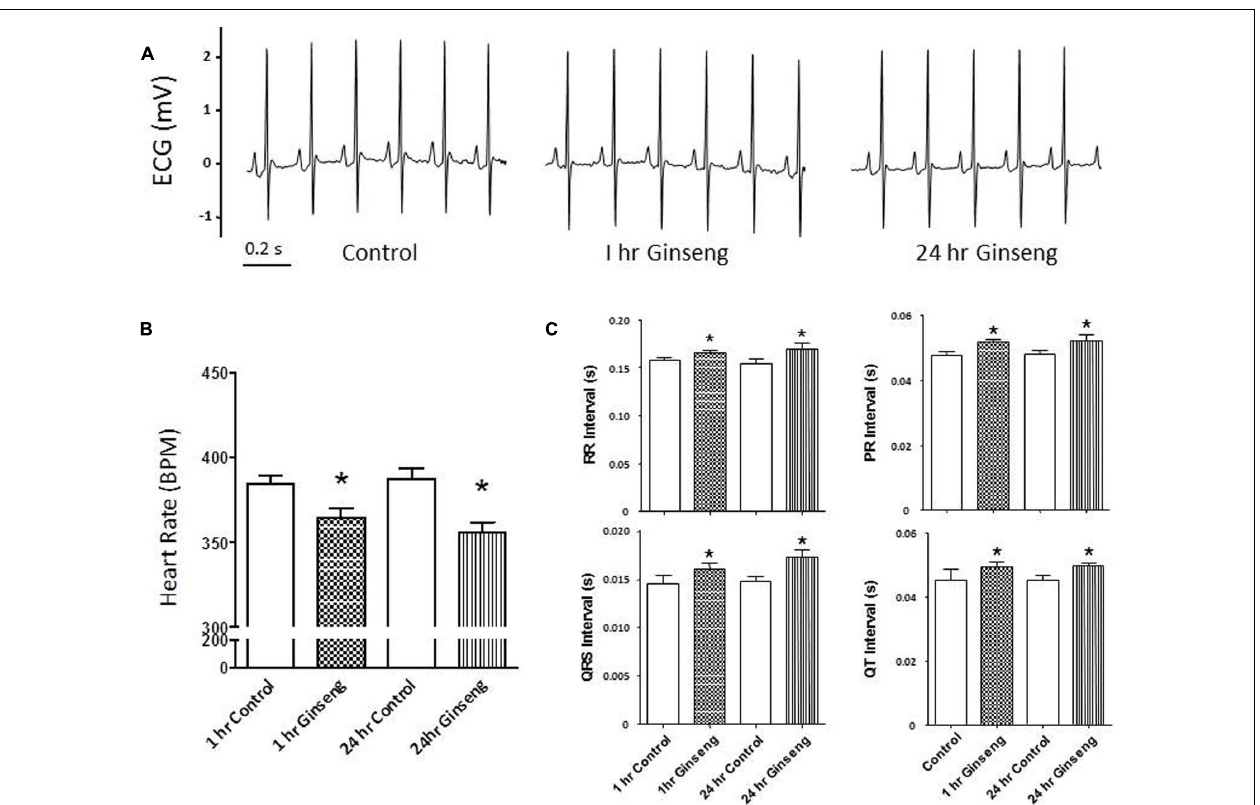
FIGURE 1 | Electrocardiogram data recorded from control animals and those treated with water-soluble ginseng ( n = 8/group; 1 and 24 h after gavaging). (A) Displays typical ECG tracings; (B) Displays